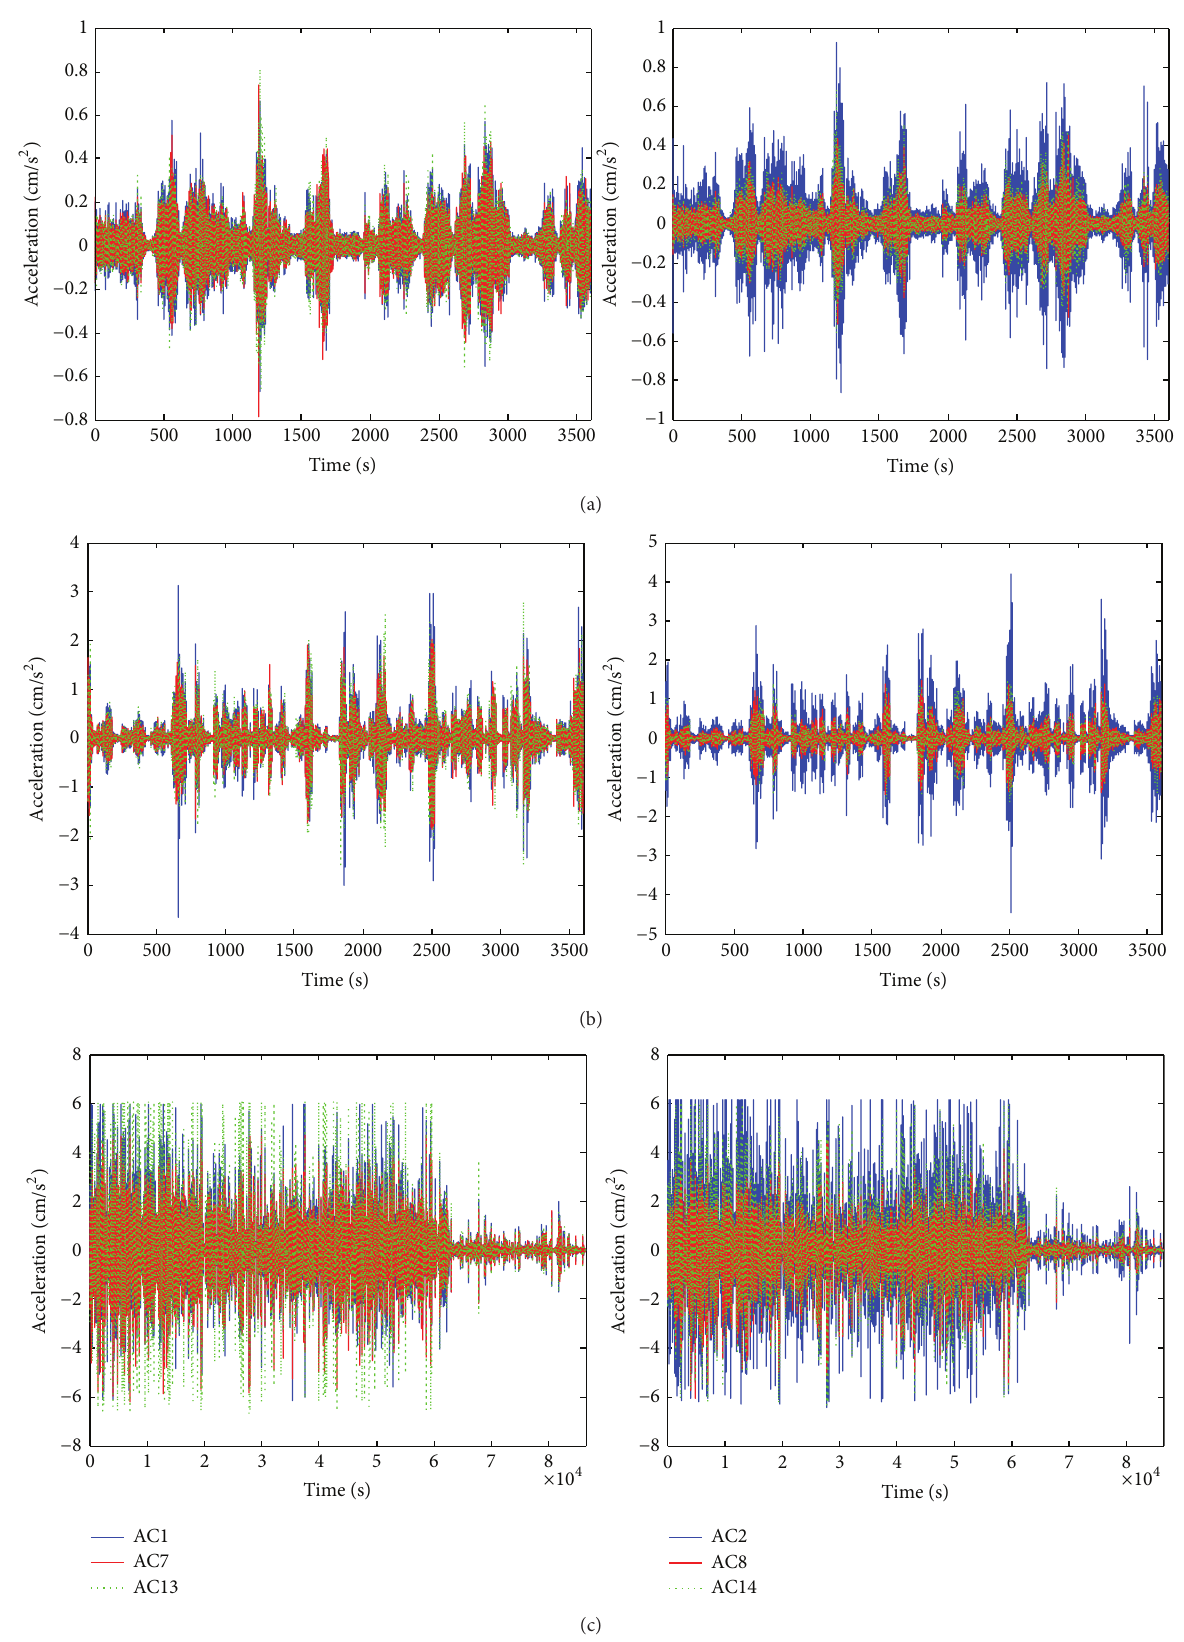
Figure 3: Acceleration monitoring for selection points at (a) Sept, 2007, (b) Jan, 2008, and (c) Jul,